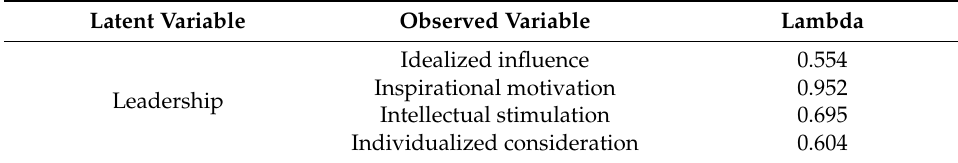
Table 4. The measurement model of leadership variable.